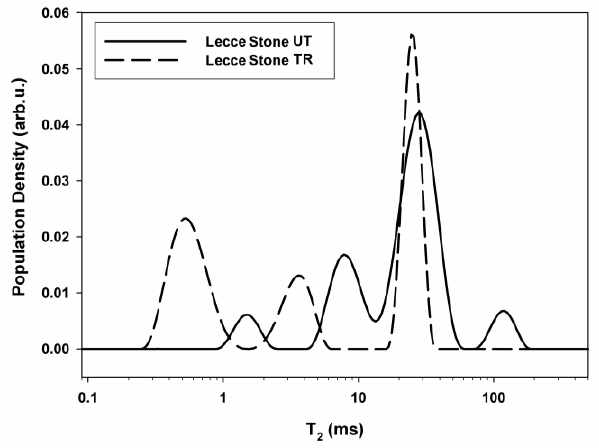
Figure 10. Transverse relaxation time distributions measured at a depth of 2 mm in Lecce stone untreated (UT) and treated (TR) with HDDA polymerized in situ